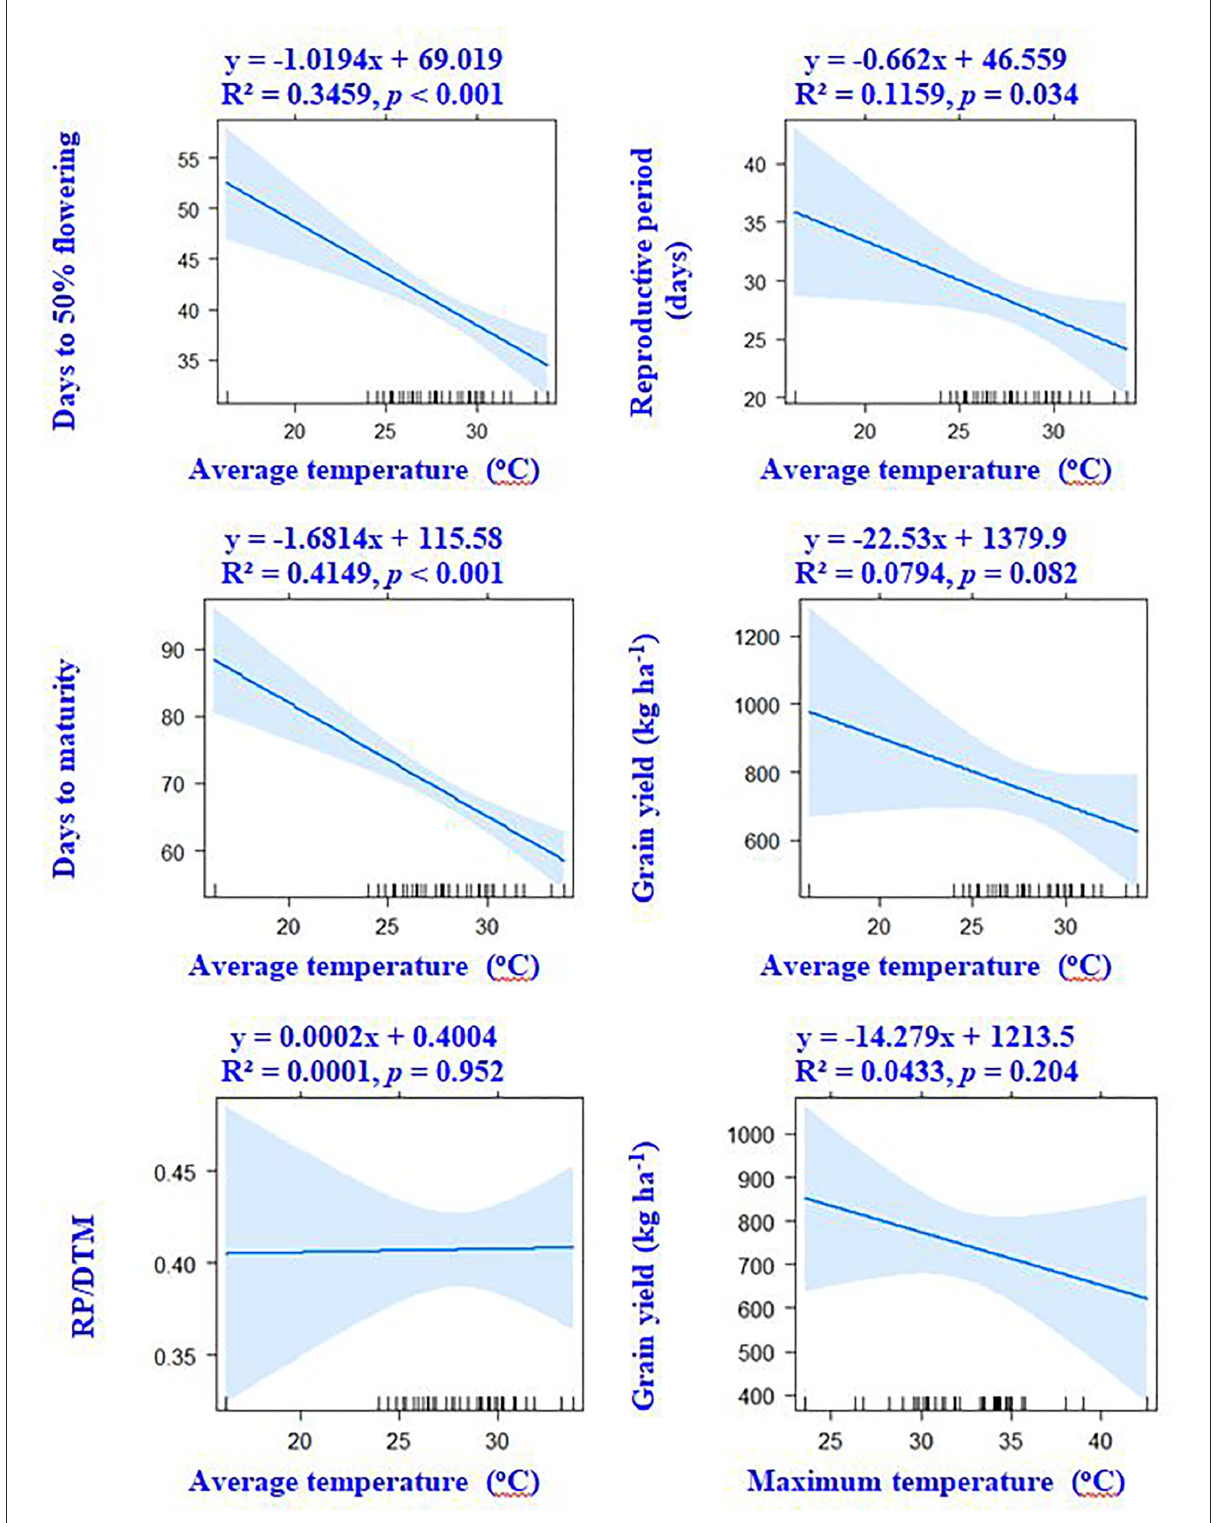
FIGURE4 Associations between crop phenology, temperature variables, and grain yield of mungbean according to linear regression